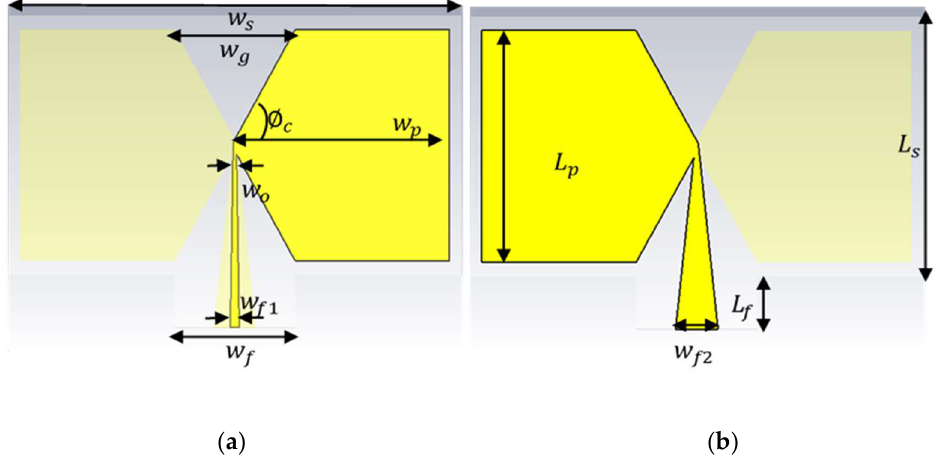
Figure 2. The geometrical shape of the proposed antenna, ( a ) front view, ( b ) back view.